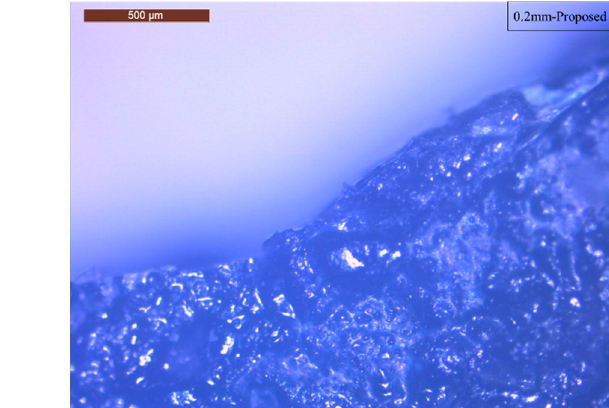
Figure 11. Microscope of the fracture of specimen 6 ( left ) & 10 ( right ).